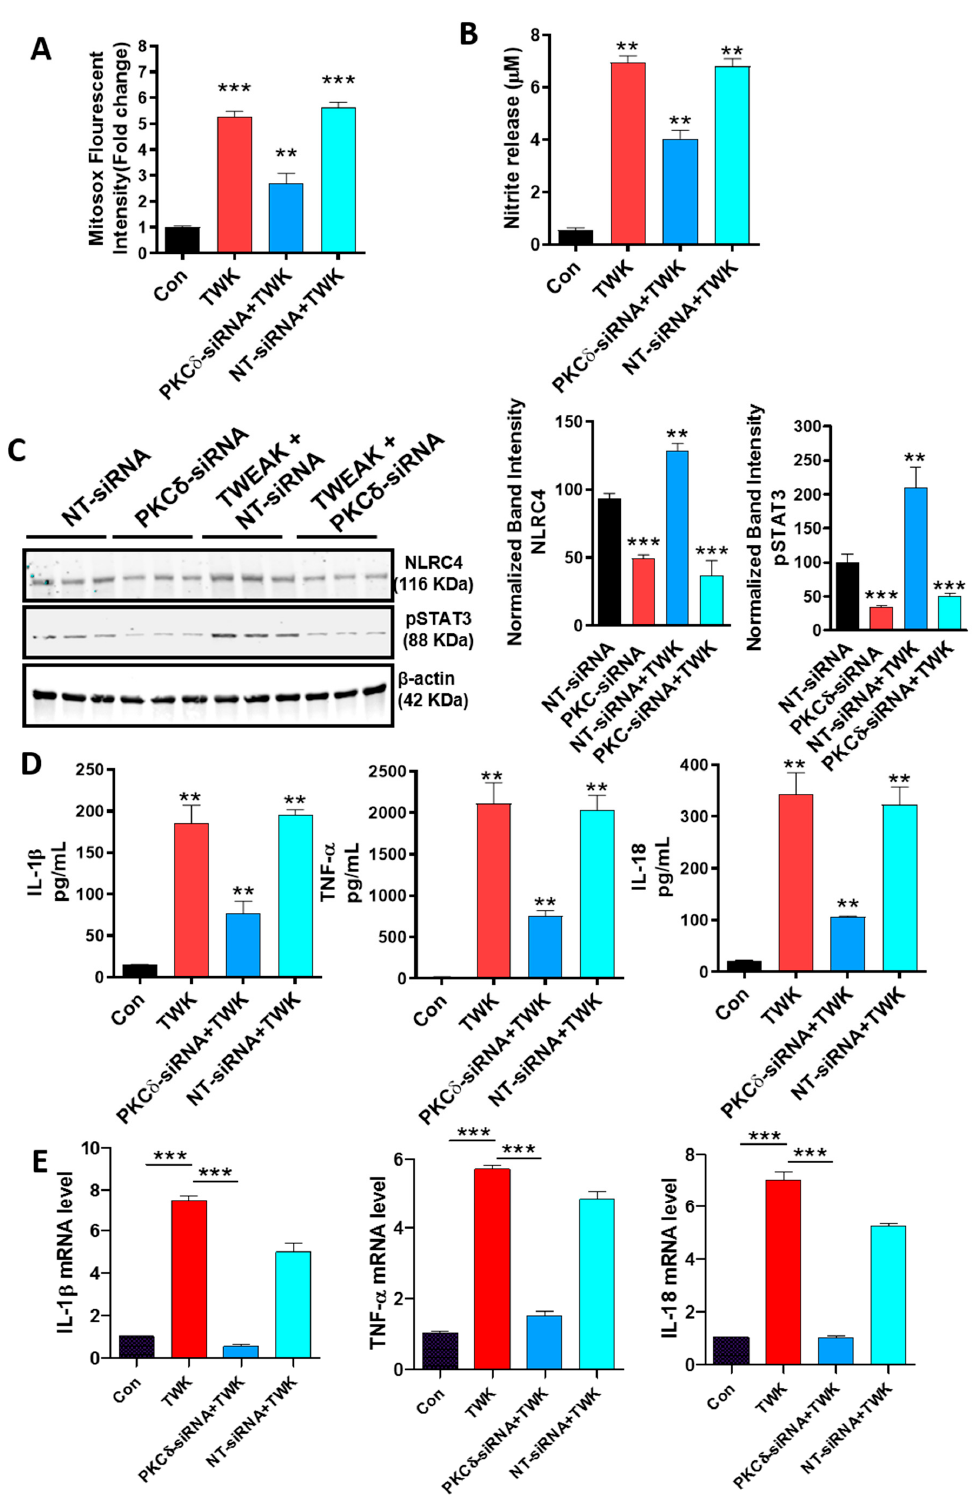
Figure 4. PKC δ regulates TWEAK-induced ROS generation, nitrosative stress and STAT3 and NLRC4 inflammasome activation in TWEAK-treated human astrocytic U373 cells. ( A – E ) Following transfection with control siRNA or PKC δ siRNA for 48 h, human astrocyte (U373) cells were treated with TWEAK (100 ng / mL) for 24 h. ( A ) MitoSox assay was conducted by incubating U373 cells with 5 µ M MitoSox dye for 20 min; the results were quantified using a fluorescence microplate reader. PKC δ specific knockdown significantly reduced the generation of mitochondrial superoxide in TWEAK-treated